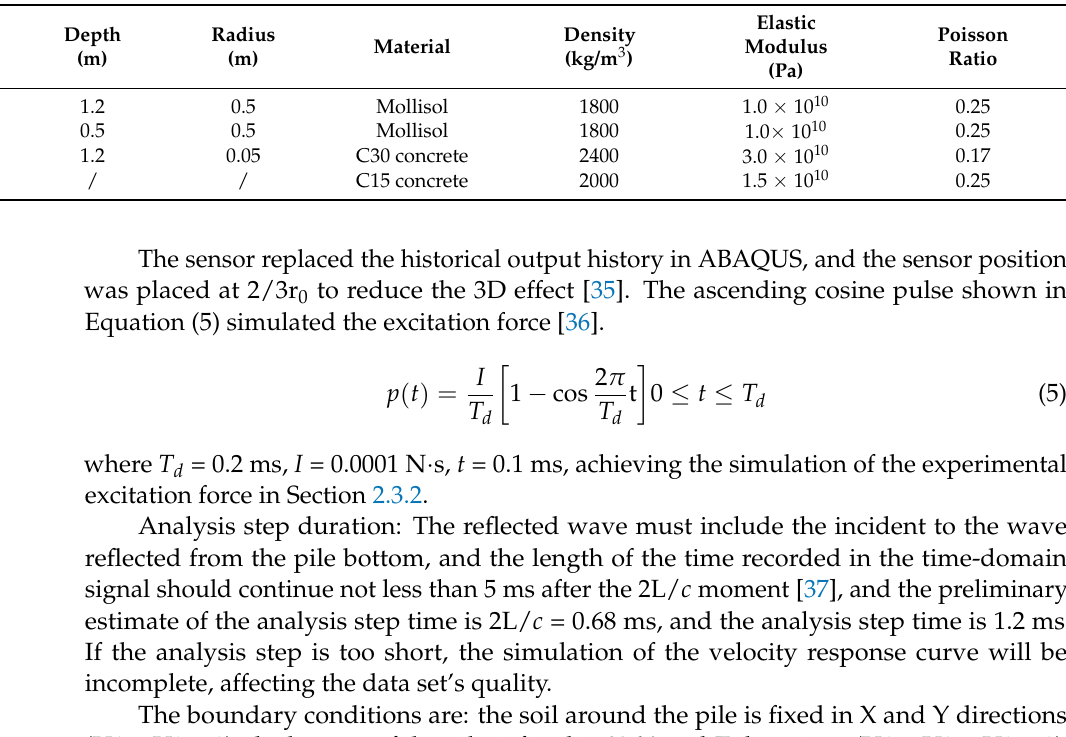
Table 1. Material parameters of pile–soil